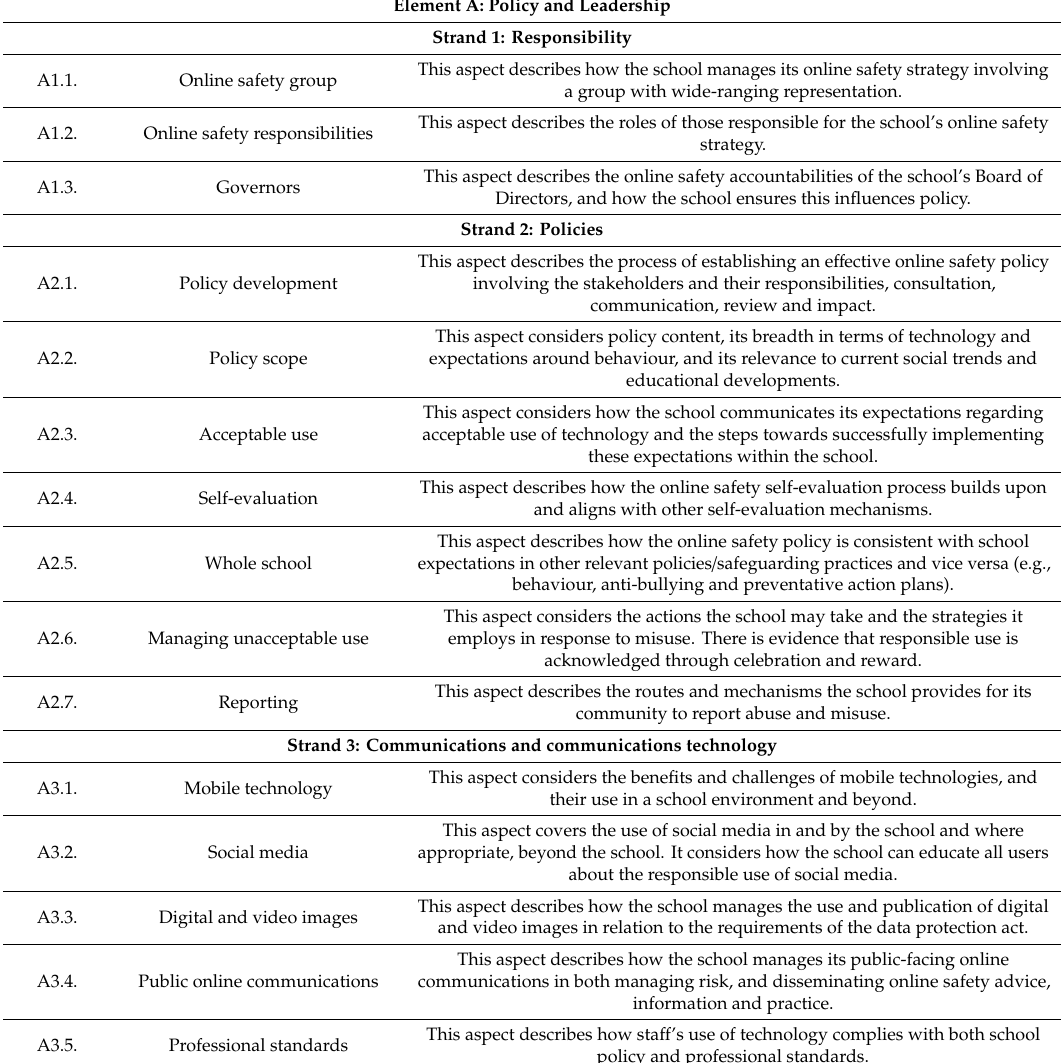
Table 1. 360safe online safety review tool (obtained from http: //